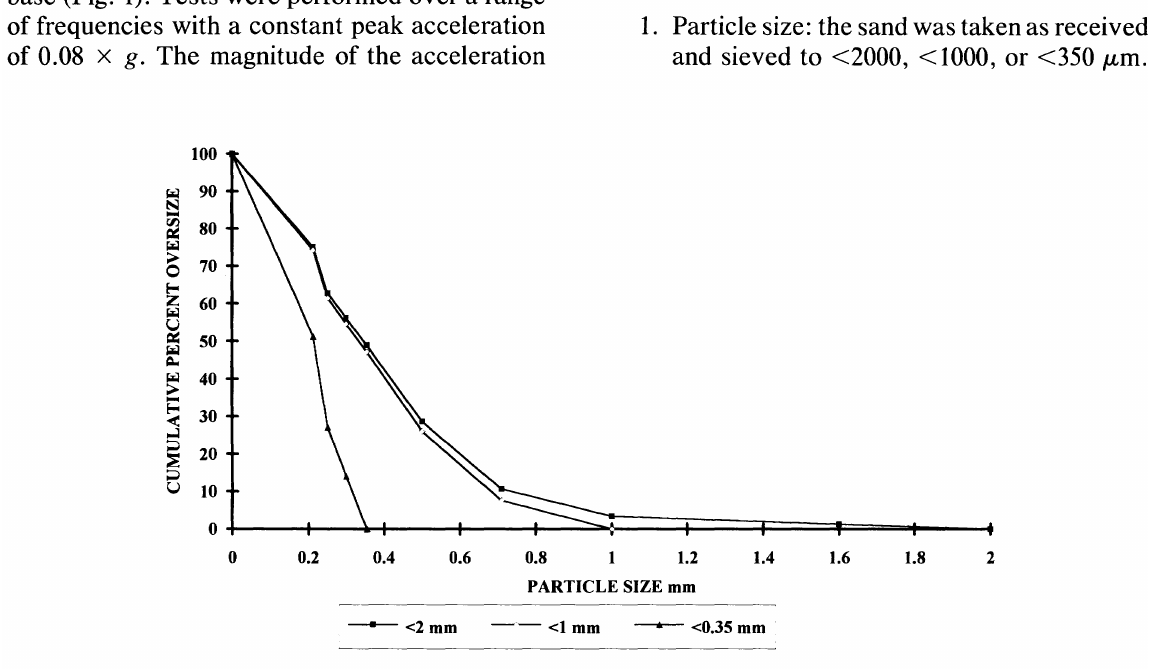
FIGURE 2 Size distribution of the sand fractions used in the